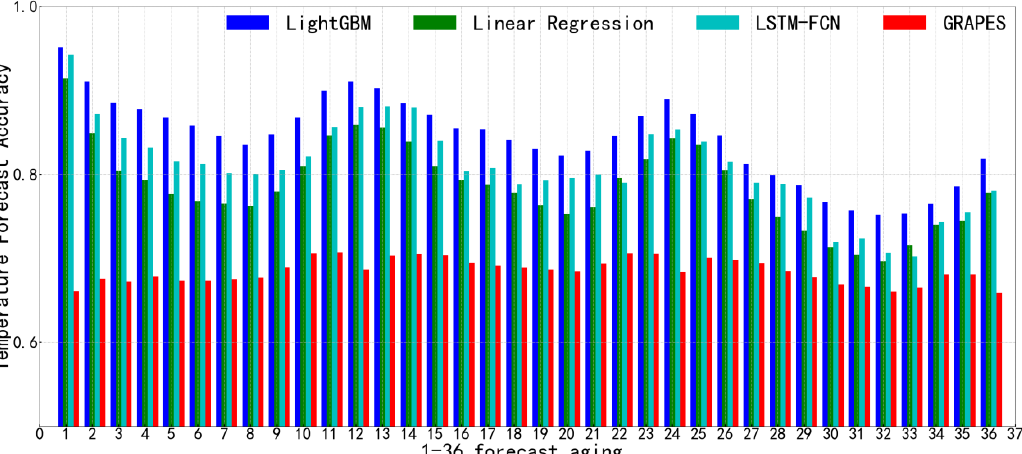
Figure 7. Comparison of the correction effects of the three methods for 1 – 36-h temperature forecast accuracy.